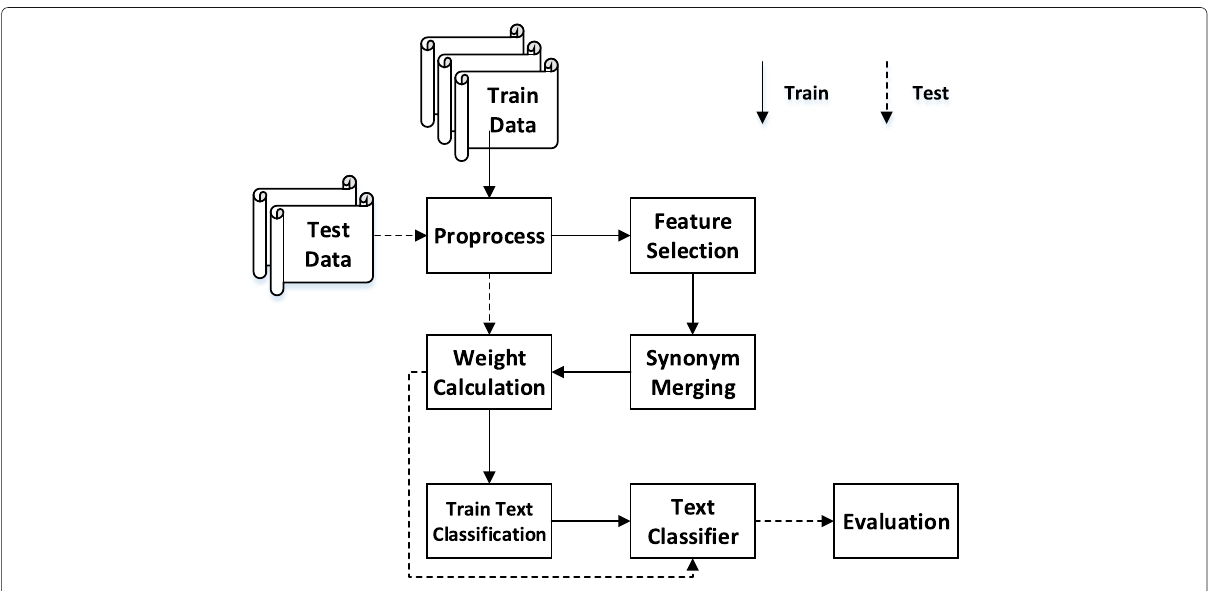
Fig. 1 Text classification model